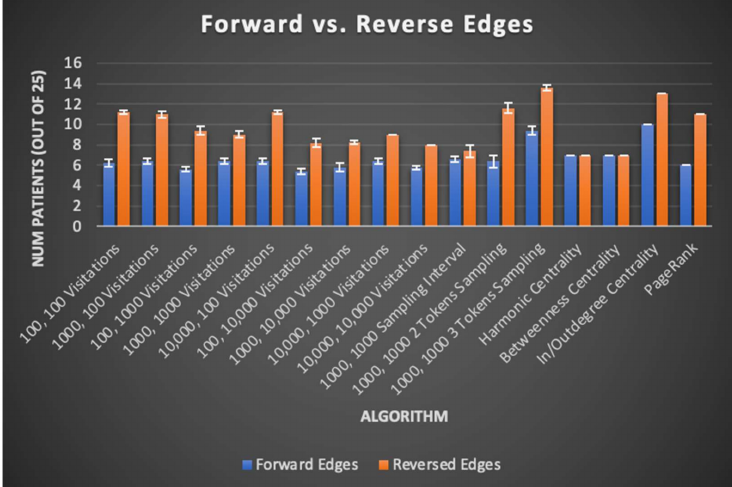
Figure 6. In this chart, sampling algorithms are described by the number of random restarts and the number of samples taken per random restart. Algorithms utilizing GC maps with forward edges include downhill sampling and indegree centrality. Algorithms utilizing GC maps with reverse edges include uphill sampling and outdegree centrality. Across nearly all algorithms tested, graph algorithms run on a reversed GC map had higher SOZ predictive capability, suggesting that interictal brain regions that cause neural activity in other regions better corelate with the SOZ rather than brain regions with the resulting neural activity